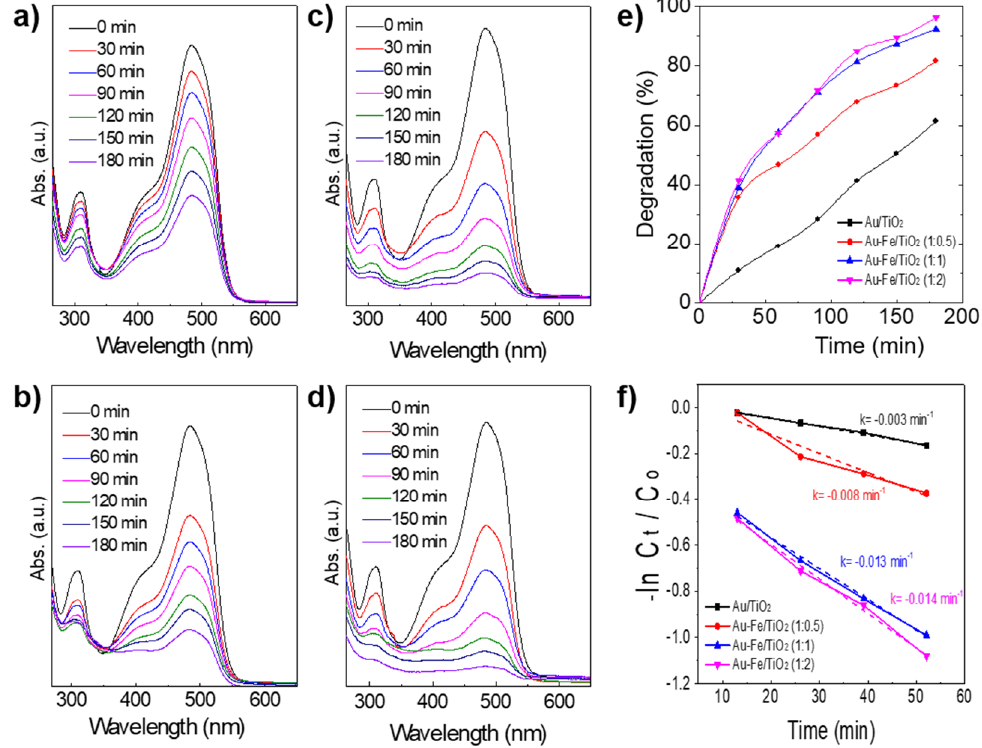
Figure 4. UV-Vis monitoring of photocatalytic degradation of 0.02 mM Orange II as a function of irradiation time on ( a ) Au / TiO 2 , ( b ) Au-Fe(1:0.5) / TiO 2 , ( c ) Au-Fe(1:1) / TiO 2 , and ( d ) Au-Fe(1:2) / TiO 2 . ( e ) Degradation vs. time; ( f ) ln(C t / C 0 ) vs. time.